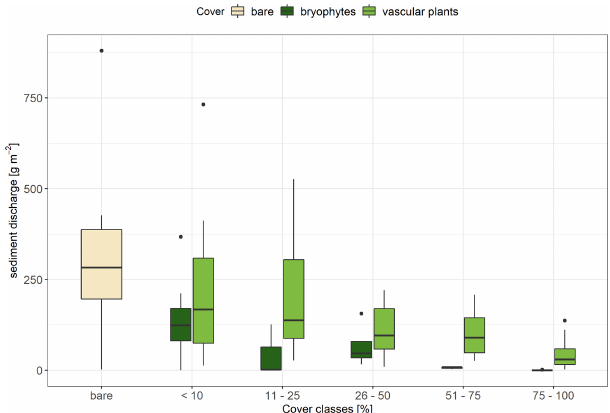
Figure 6. Sediment discharge during simulated rainfall for bare ( n = 14), bryophyte ( n = 27), and vascular-plant ( n = 58) runoff plots (ROPs) categorized into cover classes. The bottom and top of the box represent the first and third quartiles, and whiskers extend up to 1.5 times the interquartile range (IQR) of the data. Outliers are defined as more than 1.5 times the IQR and are displayed as